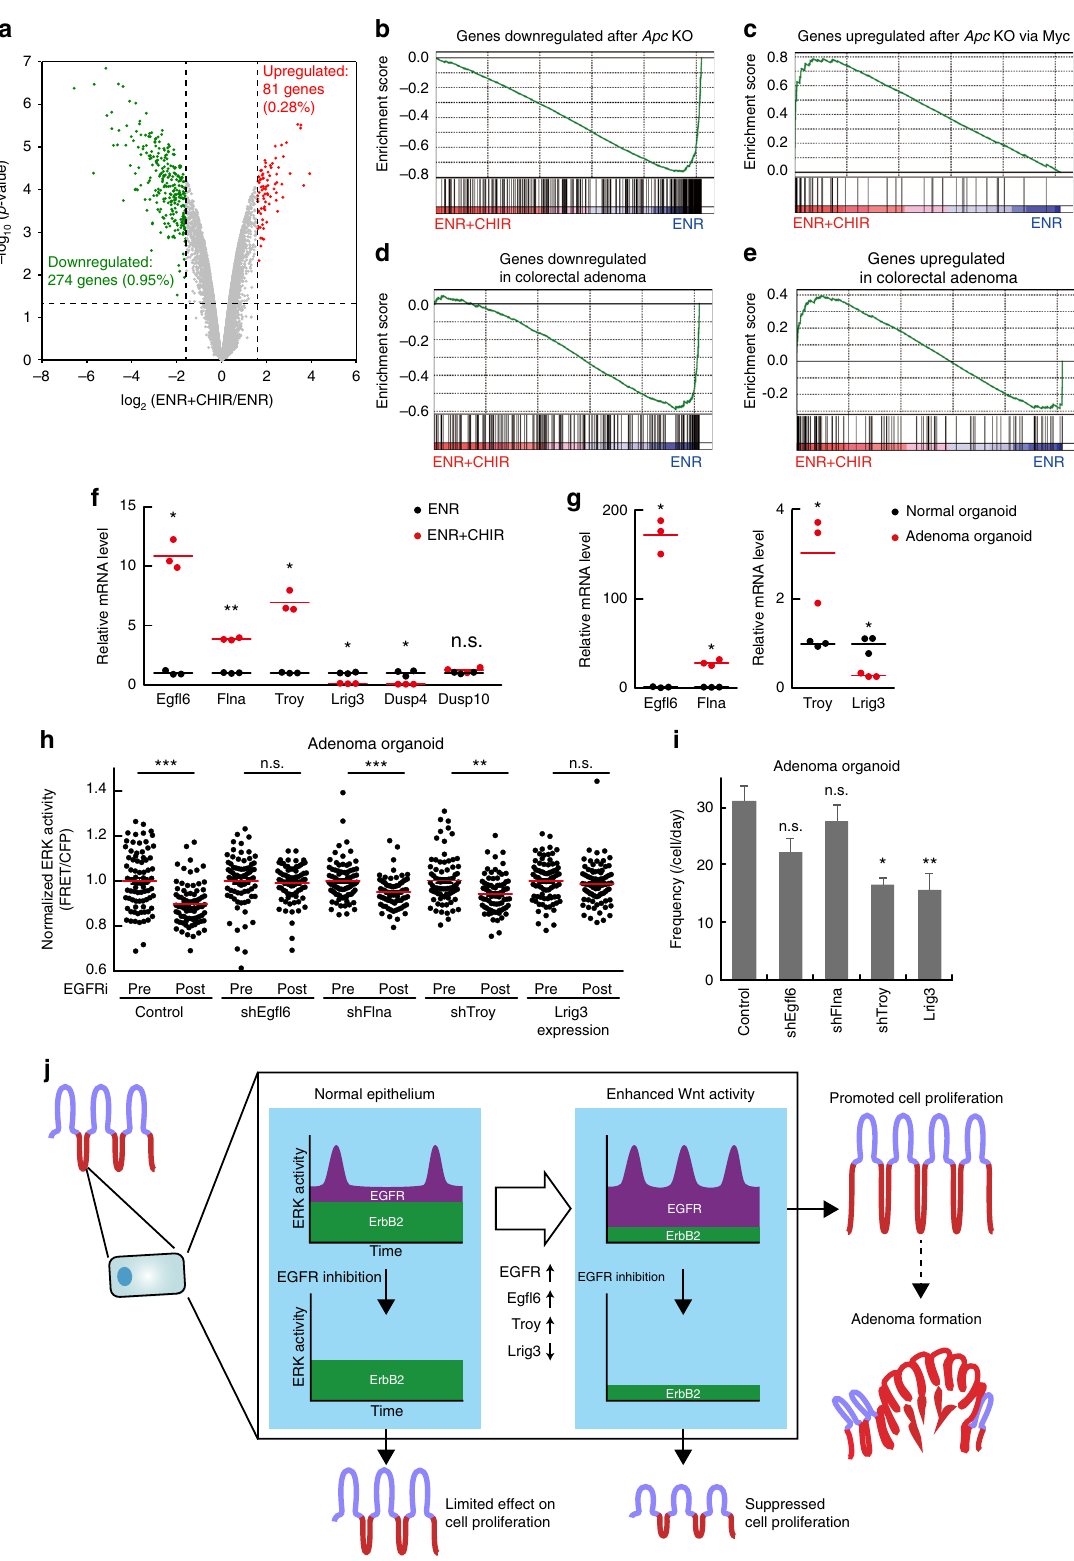
although our data could not rule out the involvement of EGFR and ErbB3 in the ErbB2 activation. In any case, our results indicate that the upstream receptors under the control of different regulatory mechanisms can generate distinct modes of ERK activity dynamics. Consistently, distinct mechanisms acting at the